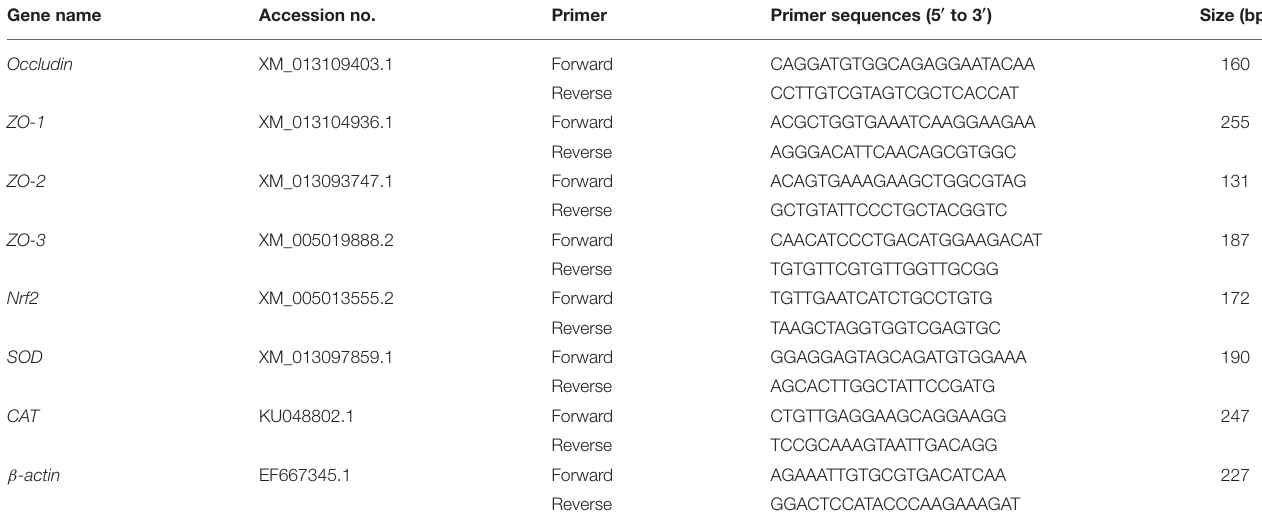
TABLE 3 | Real-time PCR primer sequences.